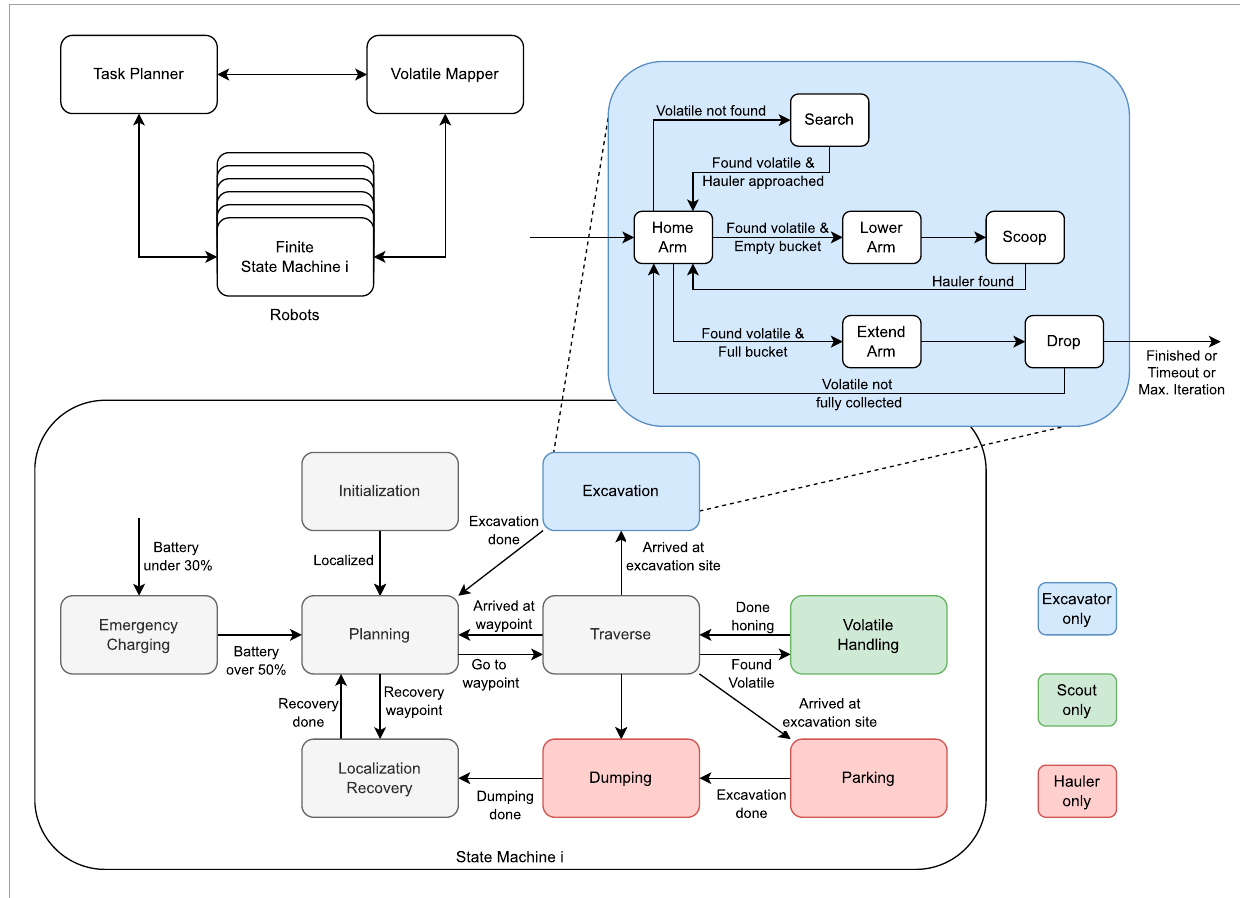
FIGURE 6 Coordination architecture for autonomous operation. A central task planner communicates and has access to the states of each individual robot, and resource collection states from a shared volatile map. The goals and resource states are updated by the task planner and the robots as their operations progress. Each robot has its behavior controlled by a Finite State Machine. Three kinds of finite state machines (FSMs) were developed, one for each type of rover. Most of the states are common (gray) to the three kinds of FSM, however, each type of rover had specialized states (colored) related to their tasks. For the Excavator, another FSM was nested to control the manipulator